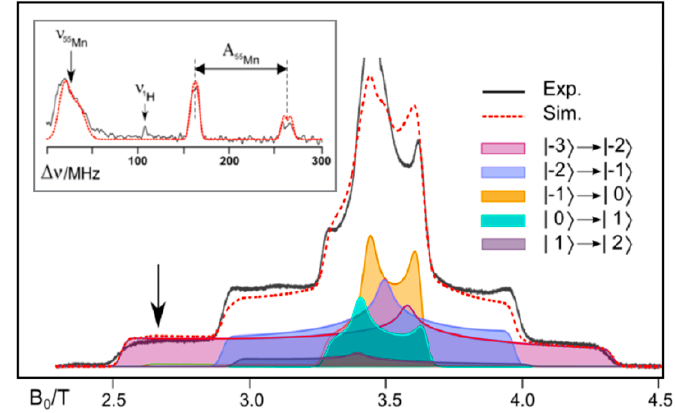
Figure 3. W-band S 3 − S 1 difference electron paramagnetic resonance (EPR) spectrum of the S 3 state from Thermosynechococcus elongatus PSII [68]. The simulation of the spectrum is indicated with the red dashed line; shaded curves show the contribution of allowed EPR transitions to the simulated powder spectrum (see color legend for assignment of specific m S transitions). Inset: W-band EDNMR spectrum showing two 55 Mn hyperfine couplings, taken at the field position of the EPR indicated with the arrow. Original data from Cox et al. [68]. Figure adapted from Möbius et al. [71].